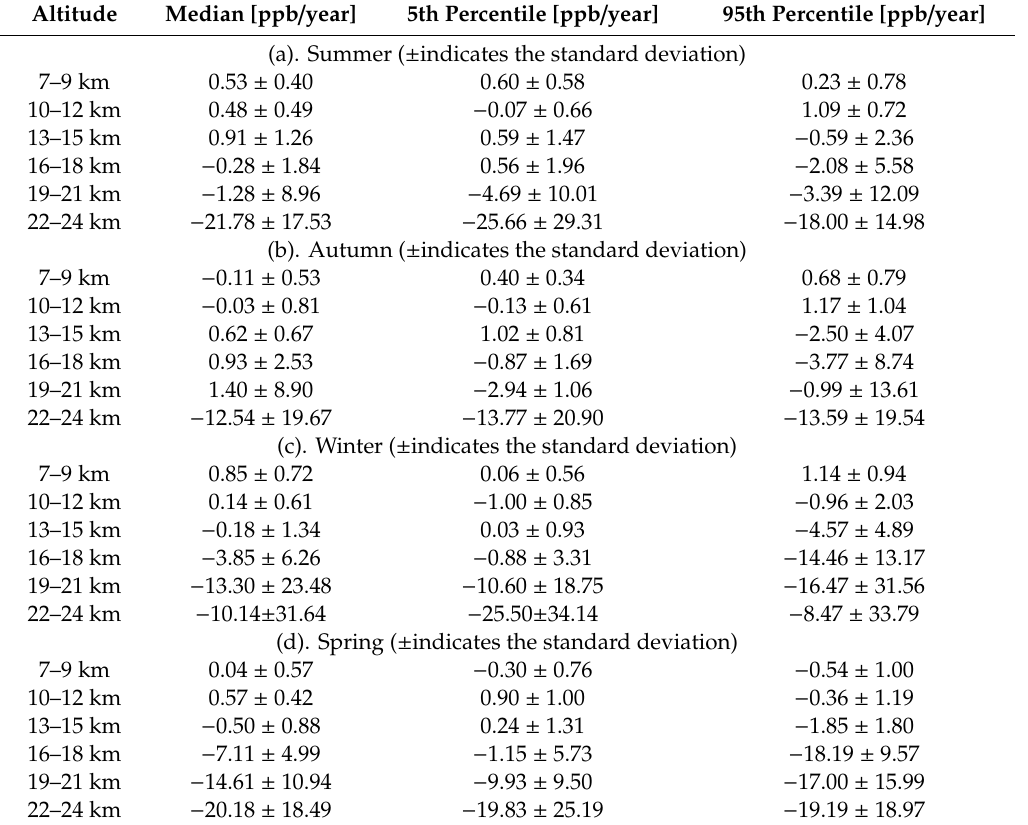
Table 4. Ozone statistical summary at di ff erent altitudes and